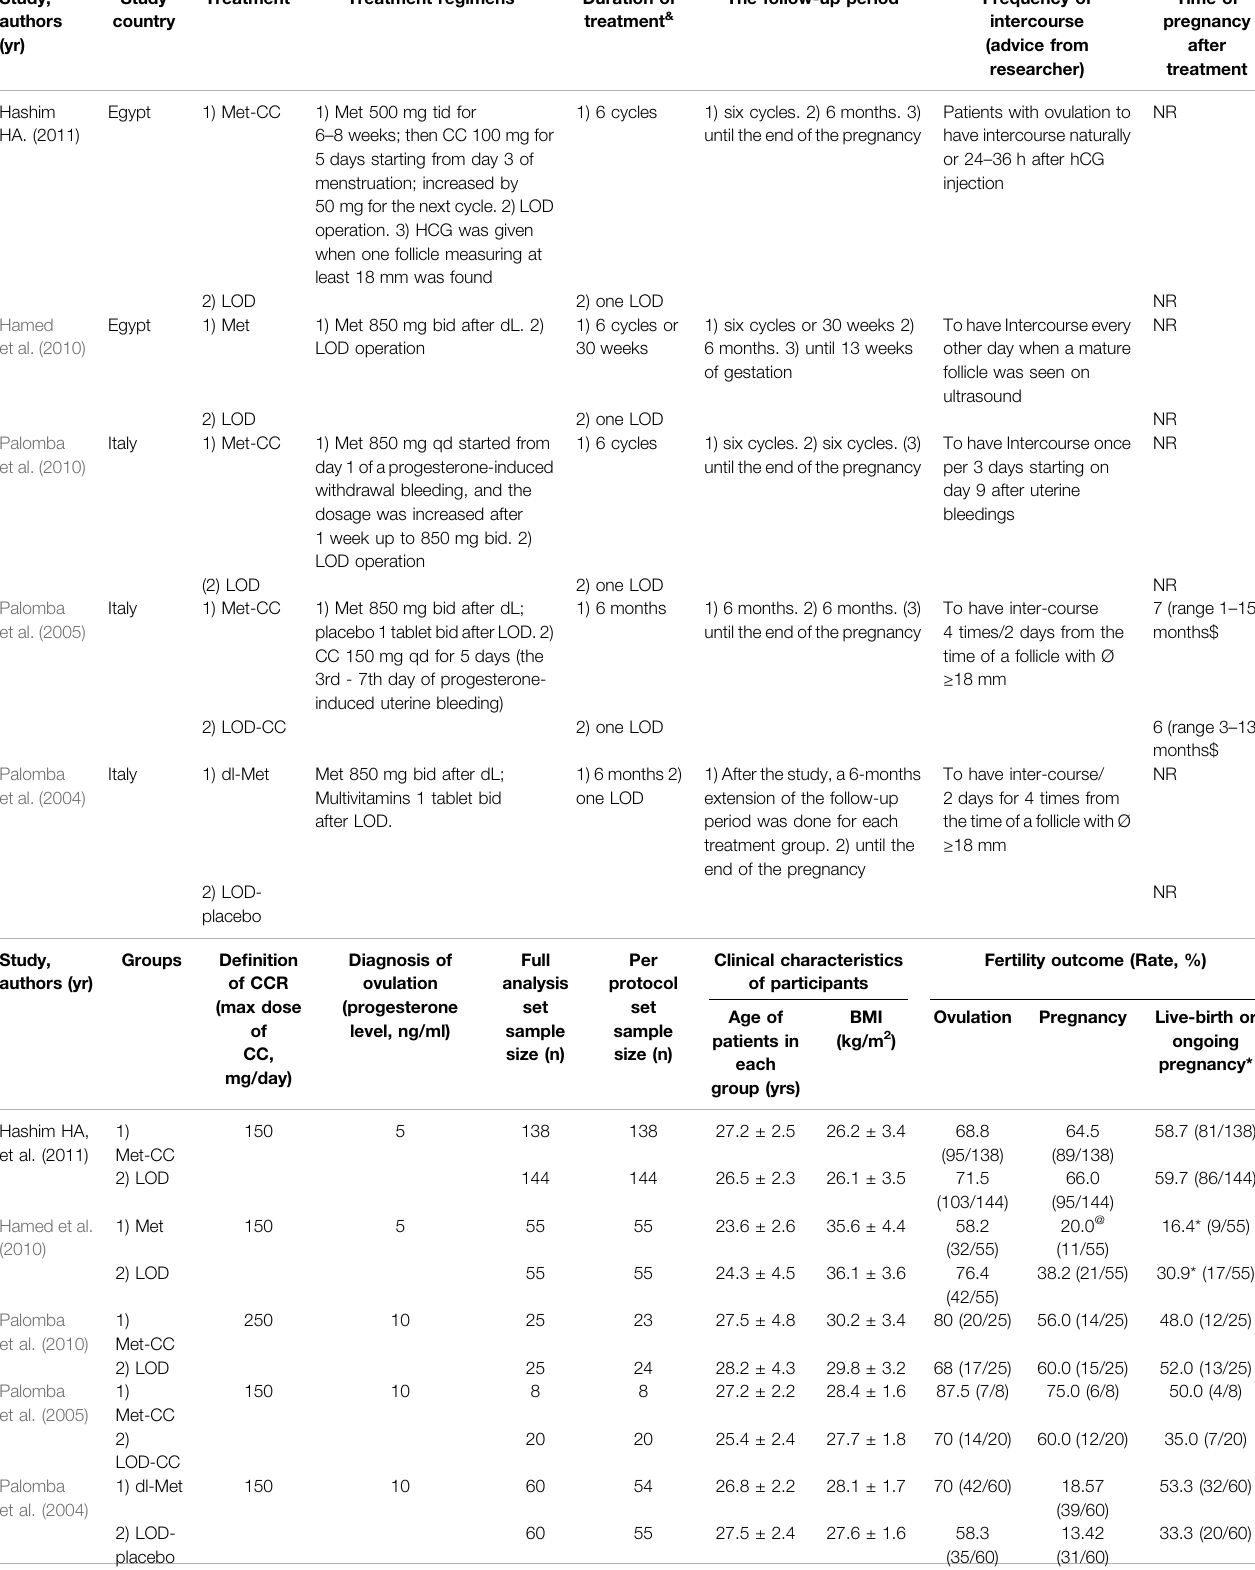
TABLE 1 | Characteristics of the included randomized controlled